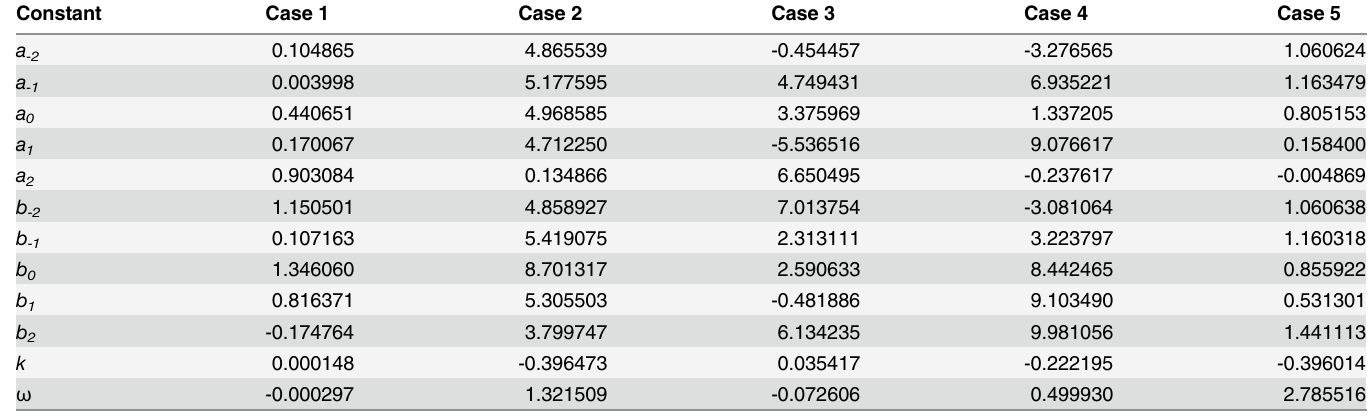
Table 2. Optimal values of unknown constants acquired by GA for example